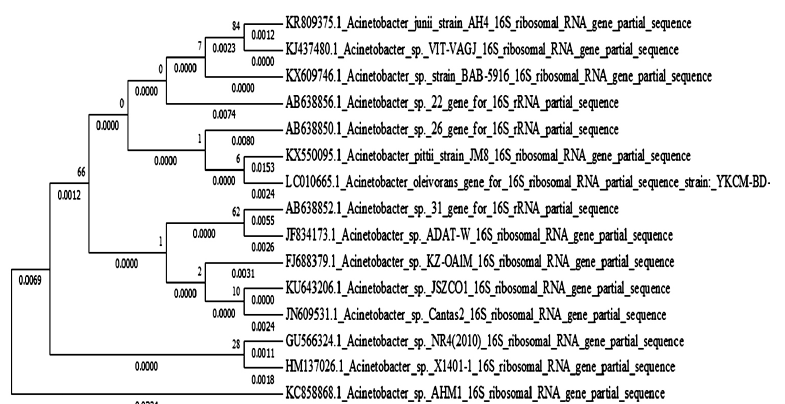
Fig. 1. Phylogenetic tree showing the relationships between strain Acintobacter junii AH4 and related